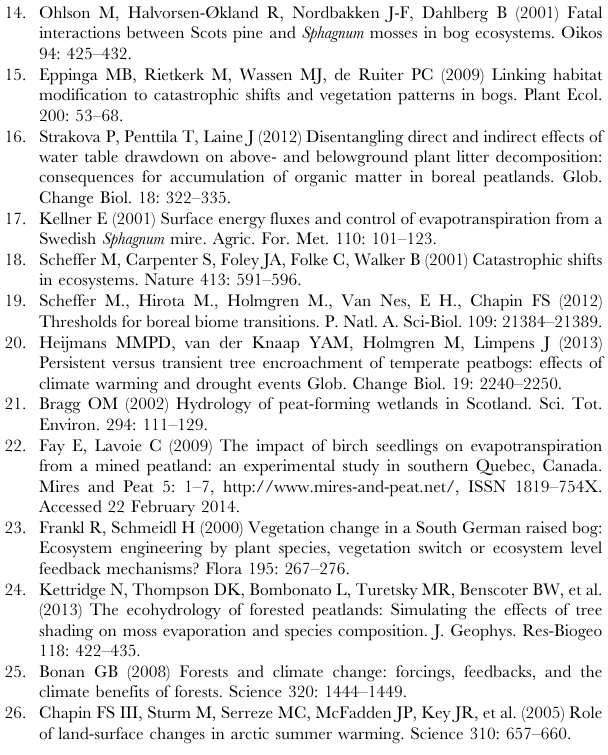
Figure S1 Layout experimental field with position plots and blocks. Figure S2 Tree density effects on subsurface tempera- ture. Table S1 Water table fluctuations under natural field conditions. Table S2 Storage coefficients (S) of mesocosms: values and measurement procedure. Table S3 Leaf area index (LAI) of plots and